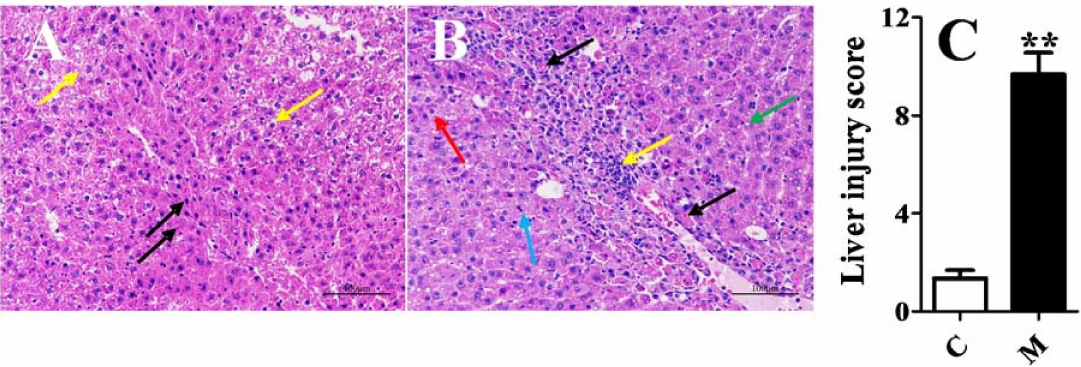
Figure 2. Pathological sections of liver, means ± SEM, n = 6, ** p < 0.01 vs. control group. ( A ) blank group: Local hepatocellular necrosis, nucleus fragmentation dissolves or pyknosis, and eosinophilic cytoplasm can be seen as shown by black arrows; degeneration of hepatocytes, swelling of cell bodies, irregular vacuoles and eosinophilic particles in the cytoplasm were shown by yellow arrows; ( B ) acute liver injury group: hepatocyte necrosis, nucleus fragmentation or dissolution, and eosinophilic cytoplasmic enhancement were shown by the black arrow; inflammatory cell infiltration was indicated by the yellow arrow; hepatic cell vesicle steatosis was shown by the green arrow; some hepatocytes in the vicinity of the necrotic lesions are degenerated, as indicated by the red arrow; pathological mitoses can be seen, as indicated by the blue arrows; and ( C ) Column chart of liver injury